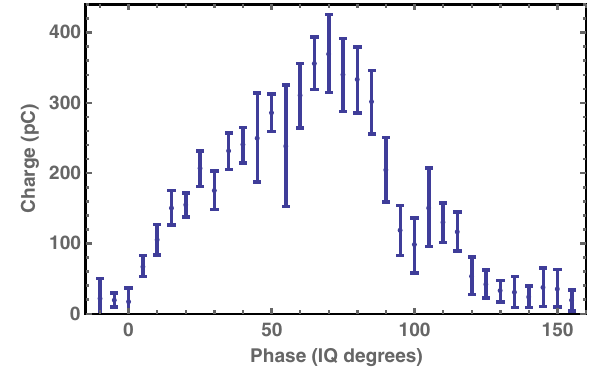
FIG. 7. Schottky scan used to determine rf phase. Shape due to capture dynamics changing at higher charge and field for fixed emittance compensation solenoid